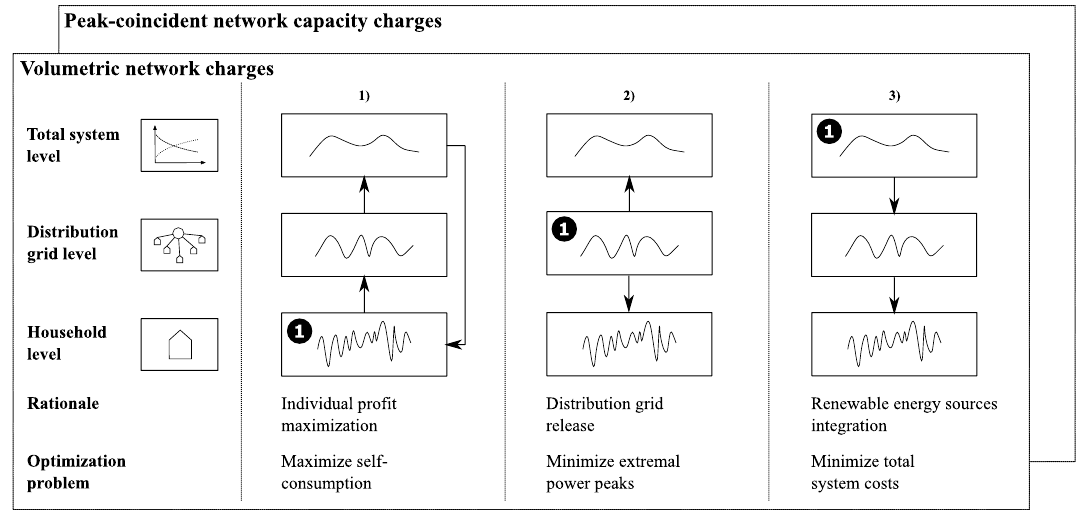
Figure 1. Workflow of analysis; encircled “1” denotes the starting point of analysis, corresponding to the respective battery operation mode (1, 2, or